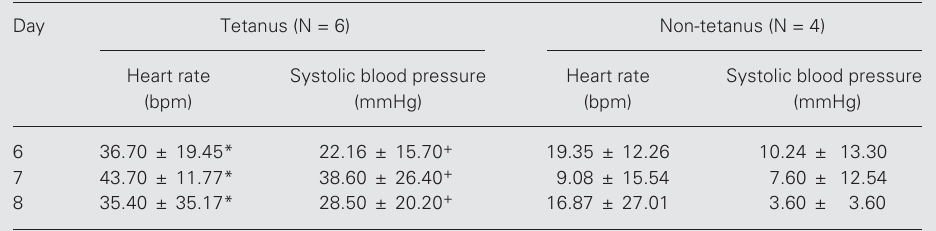
Table 2. Heart rate and systolic pressure changes in children with autonomic dysfunction secondary to tetanus and in children with diseases other than tetanus (non-tetanus).